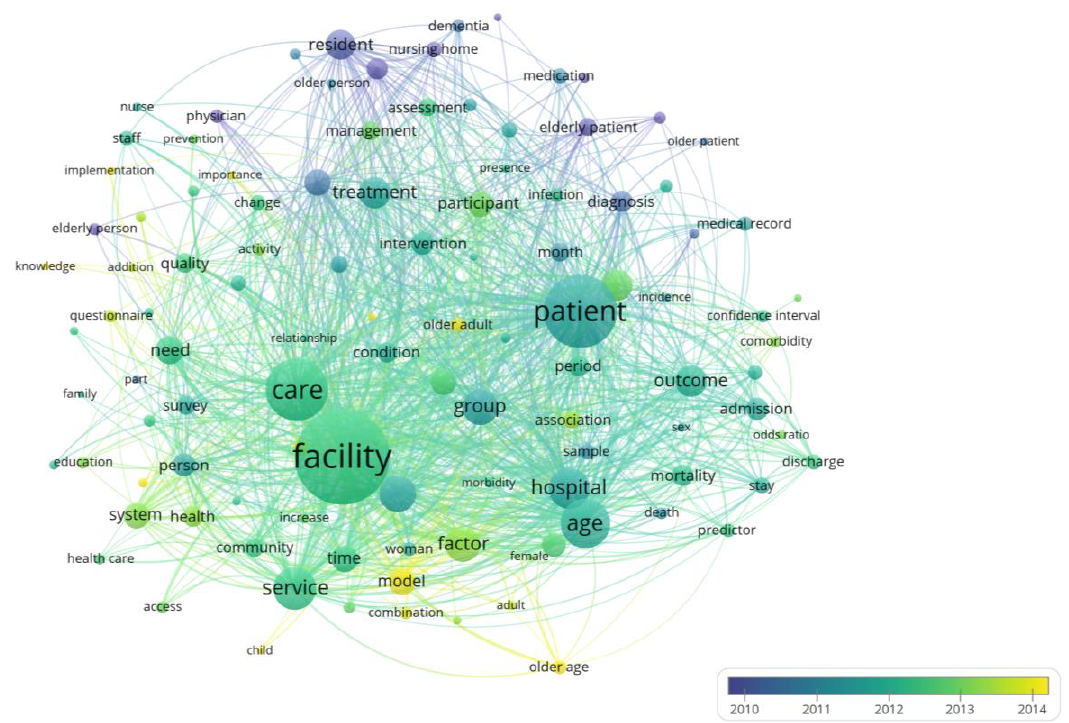
Figure 10. FCMNCE research keyword annual overlap map.